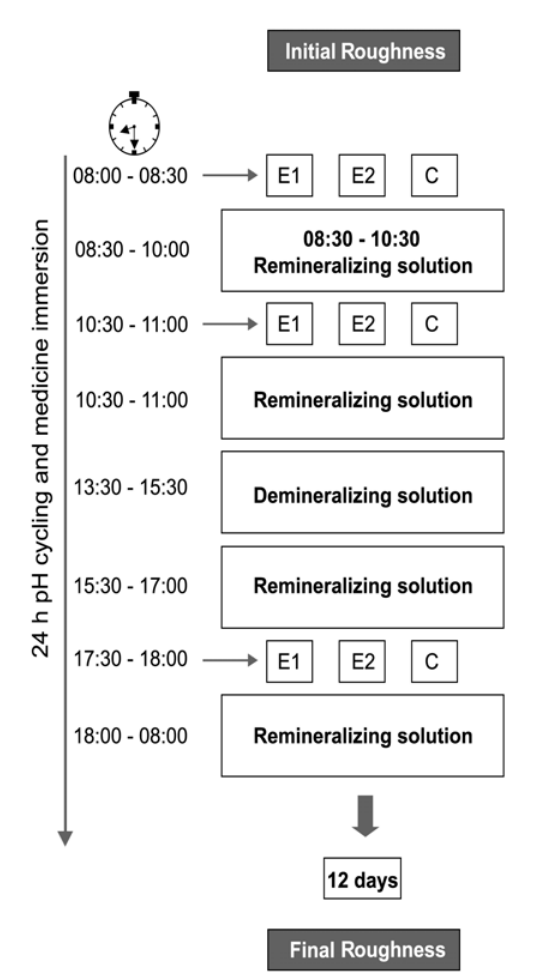
FIGURE 1- Schematic design of the pH-cycling and medicine immersion